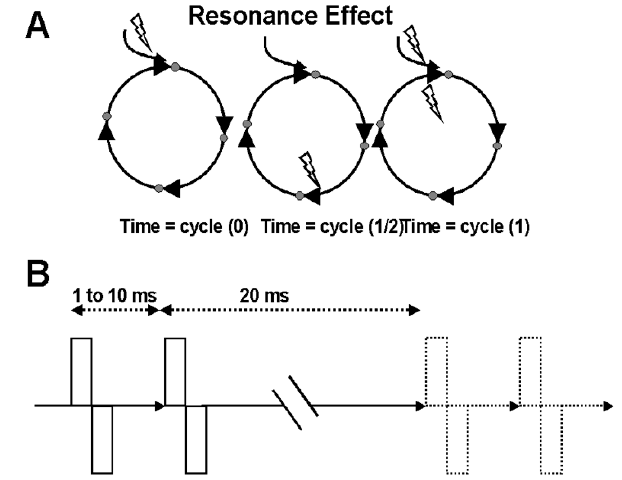
Figure 13. ( A ) A schematic representation of the resonance effect. The first stimulation (conditioning pulse) causes an excitation to traverse the closed loop. If the second stimulation (test pulse) is delivered just as the excitation effect from the first or conditioning pulse returns to the original site, the temporal summation on the neuronal cell membrane will amplify the response. ( B ) Paired-pulse stimulus trains represented schematically. The interstimulus interval represents a specific frequency (1/interval). This study examined the frequencies represented by the intervals from 1 to 10 ms (1000 Hz to 100 Hz) at 1-ms